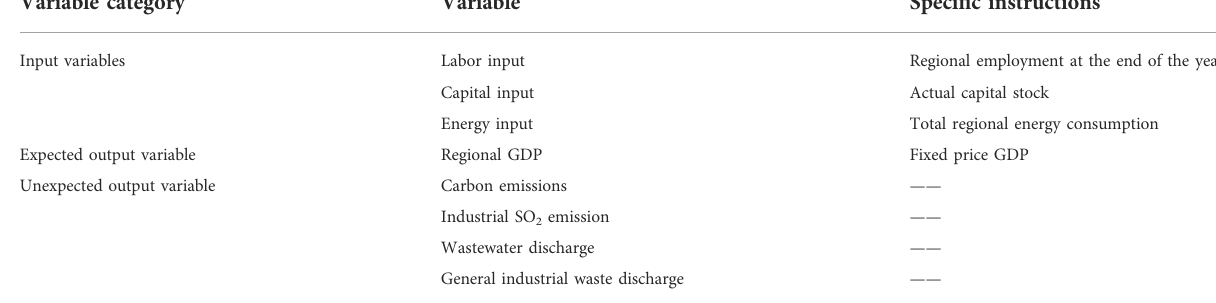
TABLE 1 Green total factor productivity evaluation